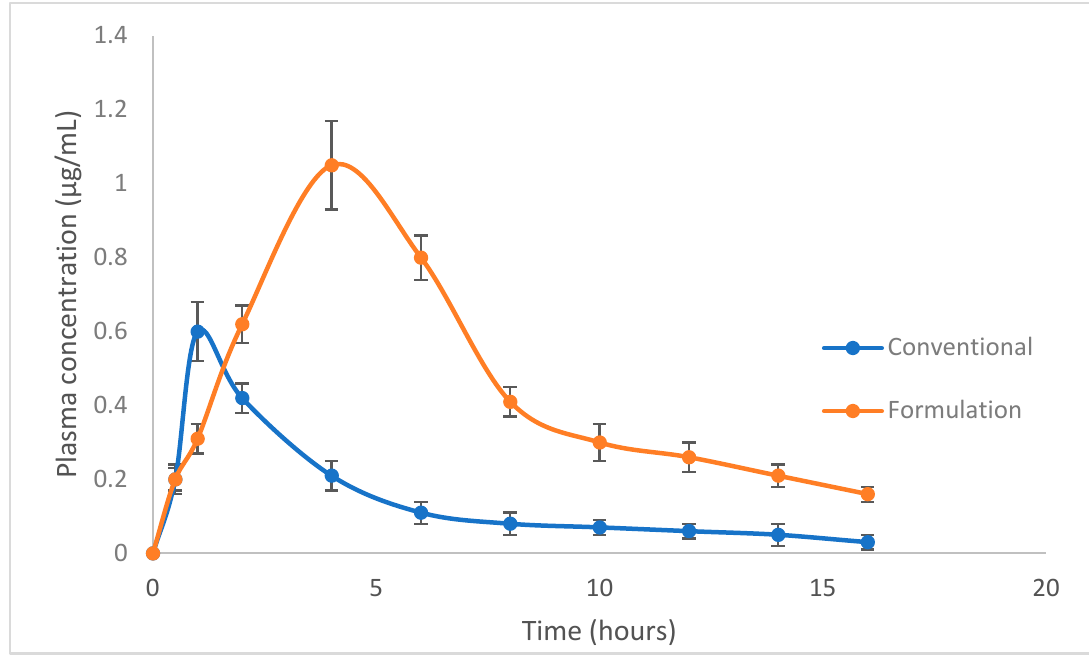
Figure 8. Pharmacokinetic study overlay. Table 5. Pharmacokinetic parameters.